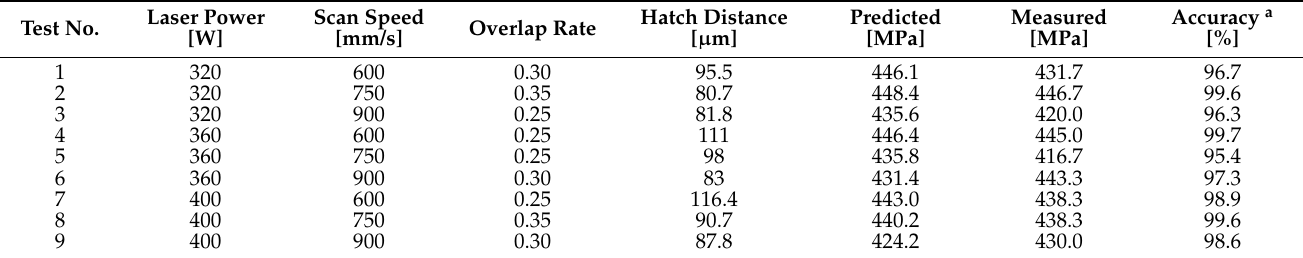
Table 7. Predicted and experimental results of tensile strength.